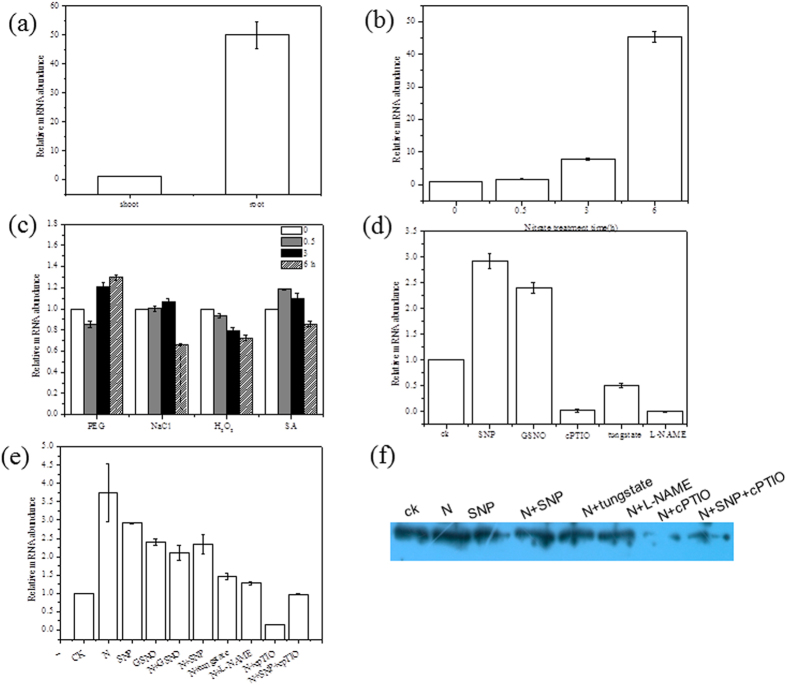
Expression characteristics analysis of SoHb.(a) Organ-specific expression of SoHb by qRT-PCR. (b) Expression of SoHb under 100 mM nitrate treatment for 0, 0.5, 3 and 6 h. (c) Expression of SoHb under PEG, NaCl, SA and H2O2 stresses. (d) Expression of SoHb under NO donor, No scavenger and inhibitor treatment. (e) Expression of SoHb under nitrate stress supplemented with NO donor, No scavenger and inhibitor. (f) Western blot analysis of SoHb under nitrate stress supplemented with NO donor, No scavenger and inhibitor. Values are means ± S.E. based on three replicates.